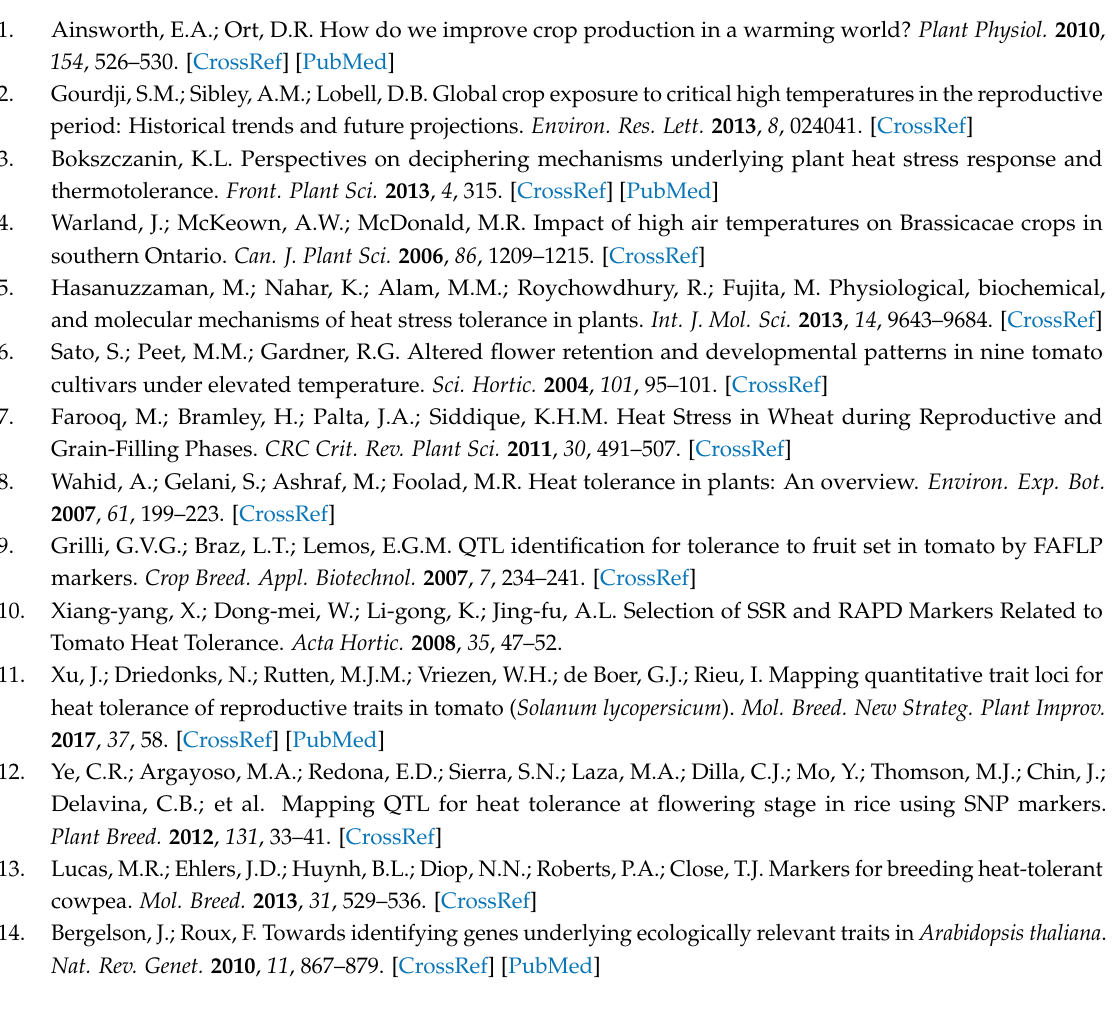
Table S1: Mean and standard error of data related to the six traits measured on each genotype during the growing season in the two experimental fields, Table S2: Pearson’s correlation among pair of traits in the two experimental fields (Pulsano and Giugliano), Figure S1: ( A ) Optimal K inferred by Structure Harvester (Evanno method), ( B ) Population structure; Each vertical bar represents one individual of the collection and each colour is proportional to the corresponding ancestry value inferred, Figure S2: Manhattan plots of GWAS analysis of the six evaluated traits in the two experimental fields (Pulsano and